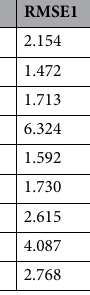
Table 2. The RMSE of the primary regression output (RMSE1), KF-modified output (RMSE2) and UKF- modified output